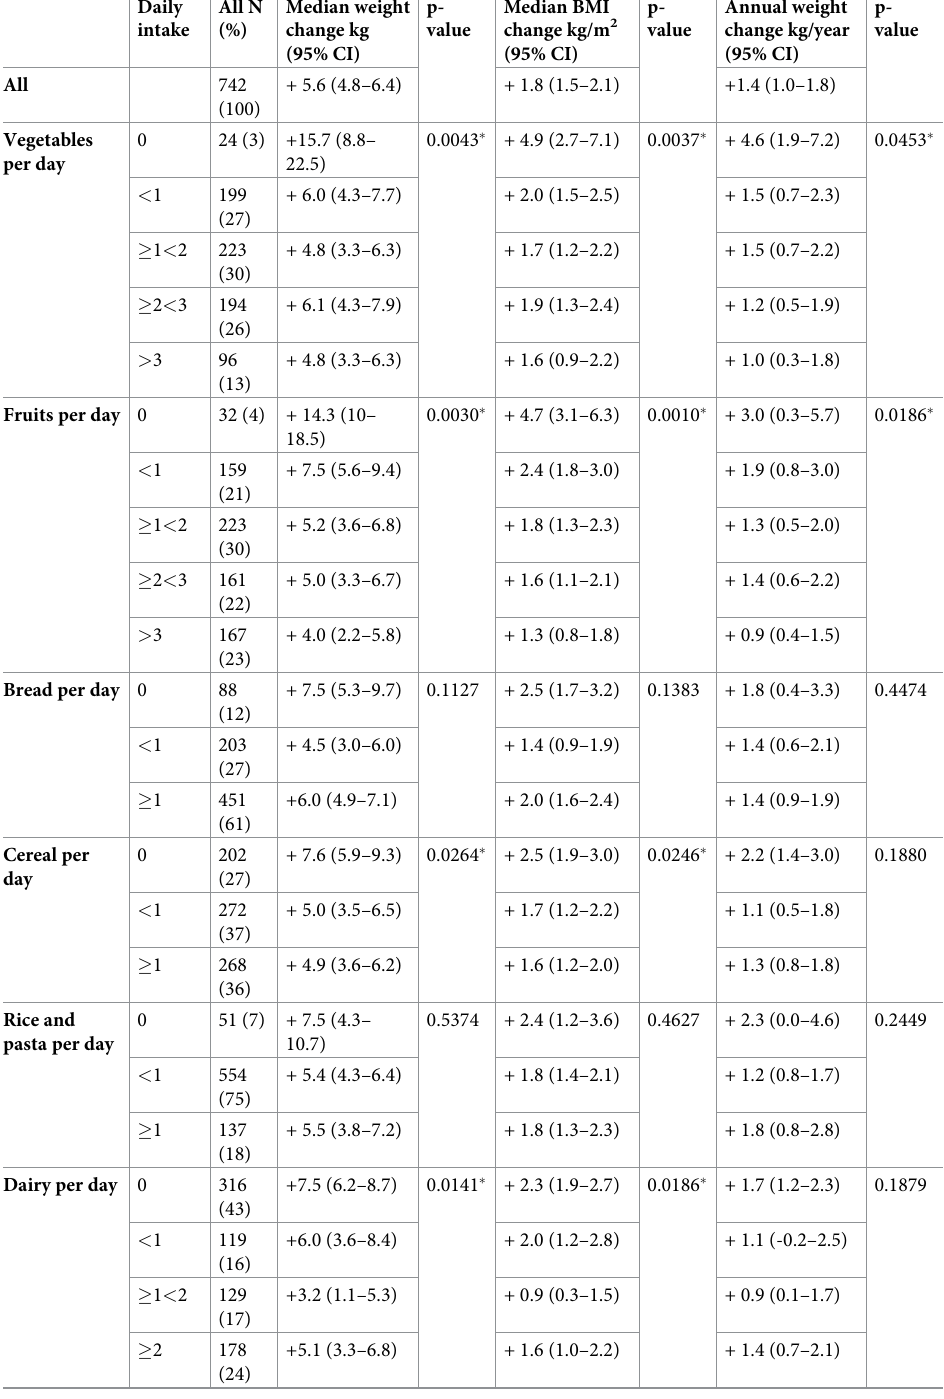
Table 4. Change in median weight, body mass index (BMI) and annual weight between admission and study fol- low-up in relation to food group intake (food frequency